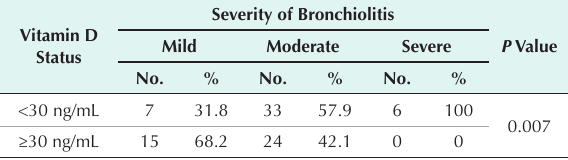
Severity of Bronchiolitis